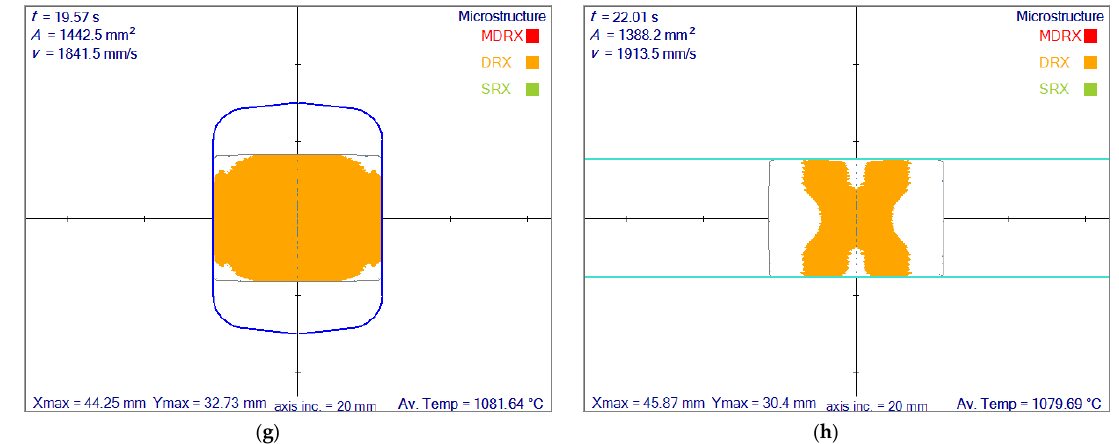
Figure 13. Recrystallization based on the model given by Yada [12] at the exit of each roll pass. ( a ) at first roll pass, ( b ) at second roll pass, ( c ) at third roll pass, ( d ) at forth roll pass, ( e ) at fifth roll pass, ( f ) at sixth roll pass, ( g ) at seventh roll pass, ( h ) at eighth roll pass. Possible recrystallization types are dynamic (DRX), meta-dynamic (MDRX) and static (SRX). Axis inc. is the length of axis increments and Av. Temps stands for average temperature.